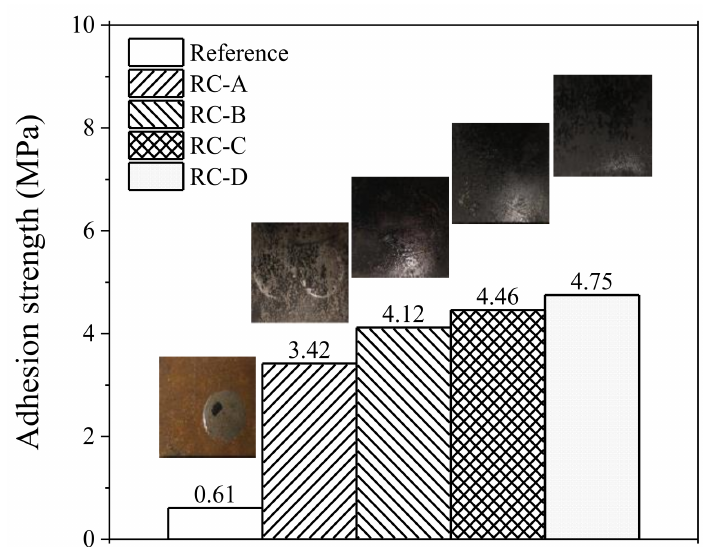
Figure 6. The adhesive strength and the failure status between passivation film and rusty